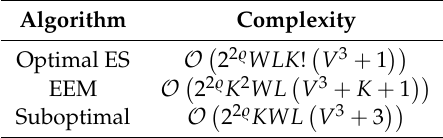
Table 1. Complexity comparison. ES: exhaustive search; EEM: energy efficiency